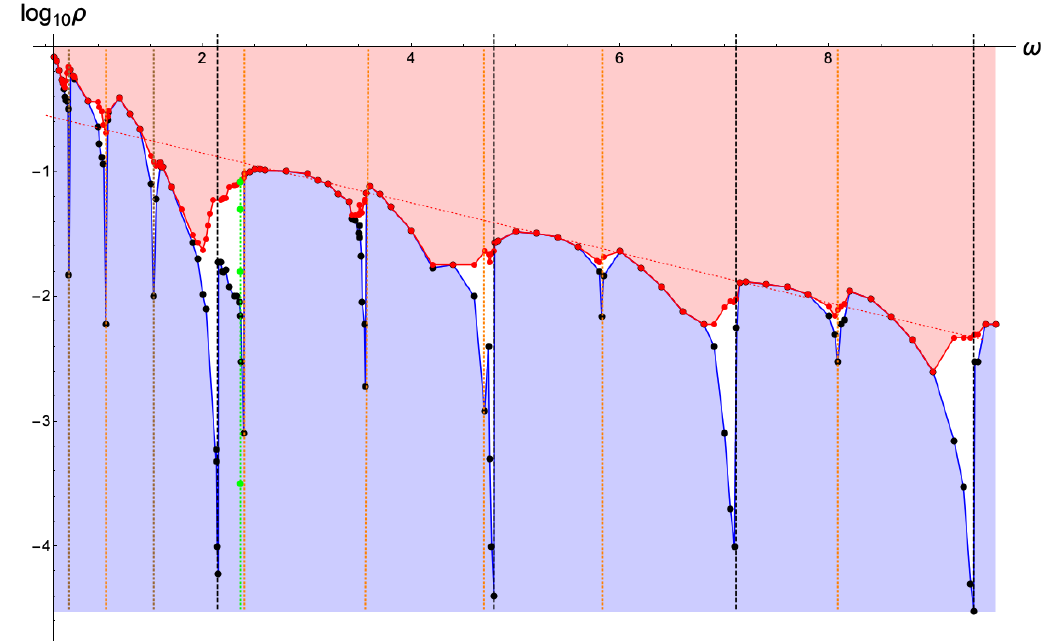
Figure 6 . In blue, regions where TPSs are reached adiabatically from the AdS-soliton (at the bottom) by means of a slow build-up of the driving amplitude (vertical path). Traversing the blue curve the solution stops being a TPS. Points in the white region correspond either to multiperiodic or chaotic solutions. The vertical dashed lines indicate the frequencies of the linearized normal modes. Their halves, (cid:10) n = 2, are signaled by dotted vertical orange segments. In brown, (cid:10) 0 = 3 and (cid:10) 1 = 3 (see (cid:12)gure 1). In green, the build-up protocol shown in (cid:12)gure 7 with the snapshots of